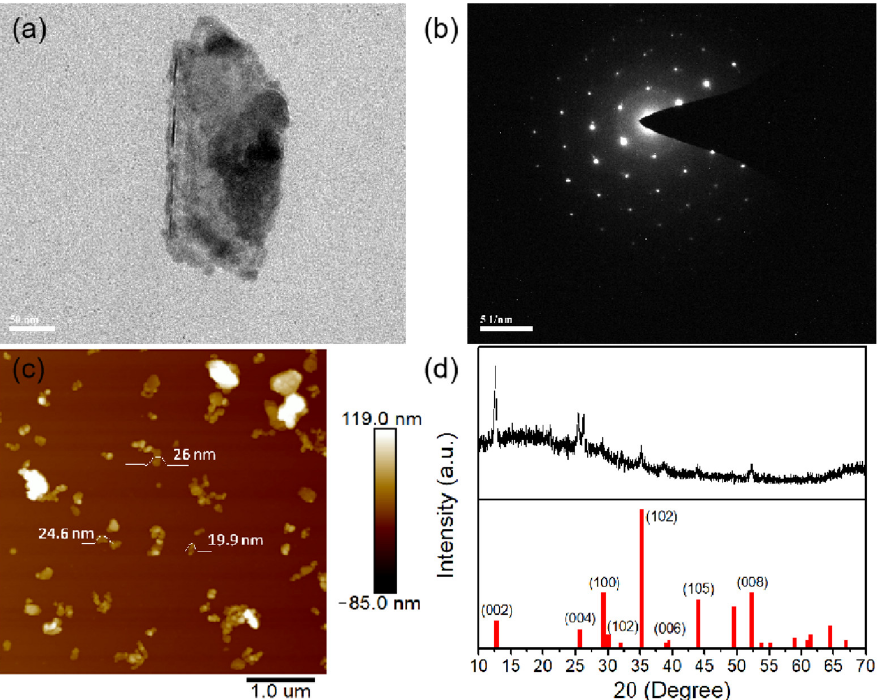
Figure 1. Characterization of few-layer MoTe 2 . ( a ) Transmission electron microscope image; ( b ) elec- tron diffraction patterns; ( c ) atomic force microscopy image and ( d ) X-ray diffraction pattern. Furthermore, we also use power-dependent transmission technology to study the saturated absorption of MoTe 2 -coated microfiber device. The experimental device is shown in Figure 2. Here, the light source used is a femtosecond laser and its parameters are: the center wavelength is 1550 nm, the pulse width is 500 fs, and the repetition frequency is 50 MHz. In the experiment, the optical transmittance under different input light intensities can be obtained by continuously adjusting the output power of the laser, as shown in Figure 2. Similar to graphene, layered MoTe 2 also has a Dirac cone structure and its saturation absorption is also caused by Pauli-blocking effect. According to the theoretical model [44], the modulation depth, saturation strength and nonsaturable loss of MoTe 2 -assisted tapered fiber devices are about 4.45%, 40 MW/cm 2 and 40%, respectively. In this experiment, the insertion loss of MoTe 2 -assisted fiber taper is about 3.5 dB. In the future, it is expected to obtain higher quality saturable absorbers by optimizing the fabrication process of fiber taper and the thickness and uniformity of MoTe 2 nanosheets. As mentioned above, the direct band gap of single-layer MoTe 2 is about 1.25 eV, and the corresponding operation wavelength is about 993 nm, while the operation wavelength in this work is 1550 nm, showing a slight sub-bandgap absorption phenomenon, which may be caused by defects, two-photon absorption or edge-mode absorption. As shown in Figure 1c, the prepared MoTe 2 nanosheets exhibit uneven thickness and shape distribution, which may lead to relatively high absorption near 1550 nm.